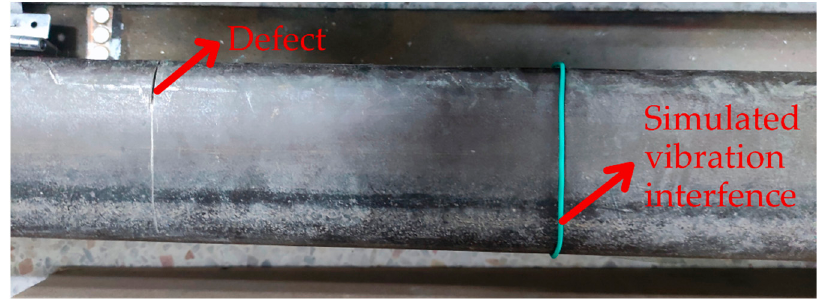
Figure 10. A rail with an artificial defect.